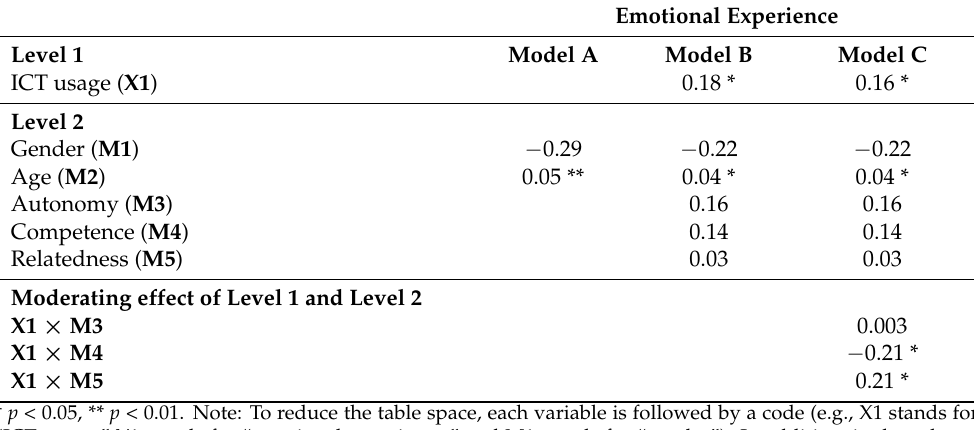
Table 3. Hierarchal linear modeling analysis of using ICT to predict emotional experience.